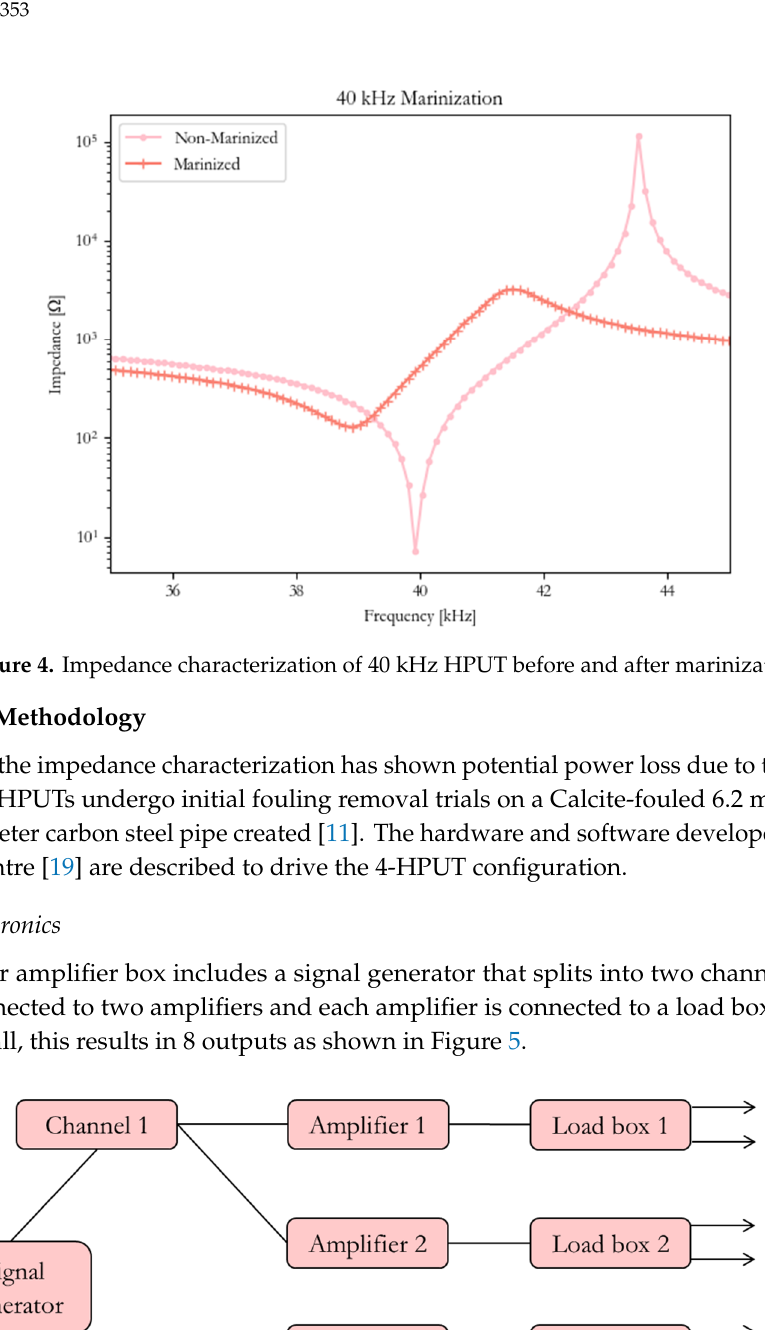
Figure 5. Power electronics system schematic.